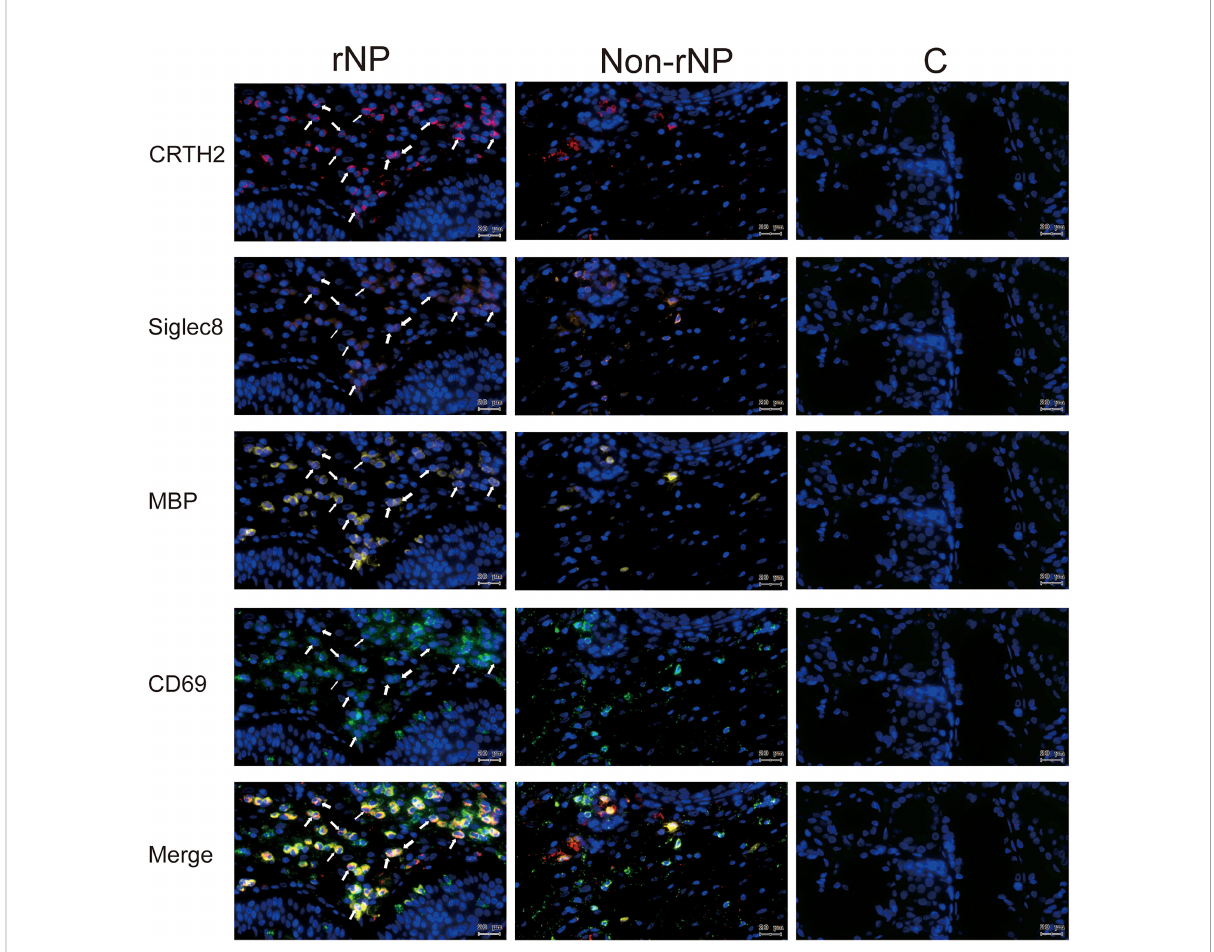
FIGURE 6 Representative tissue images stained using multiplex immuno fl uorescence staining for CRTH2 (red), Siglec8 (orange), MBP (yellow), CD69 (green), and DAPI (blue) in rNP group, Non-rNP group, and control group. White Arrows indicated eosinophils that expressed the corresponding markers. C, control